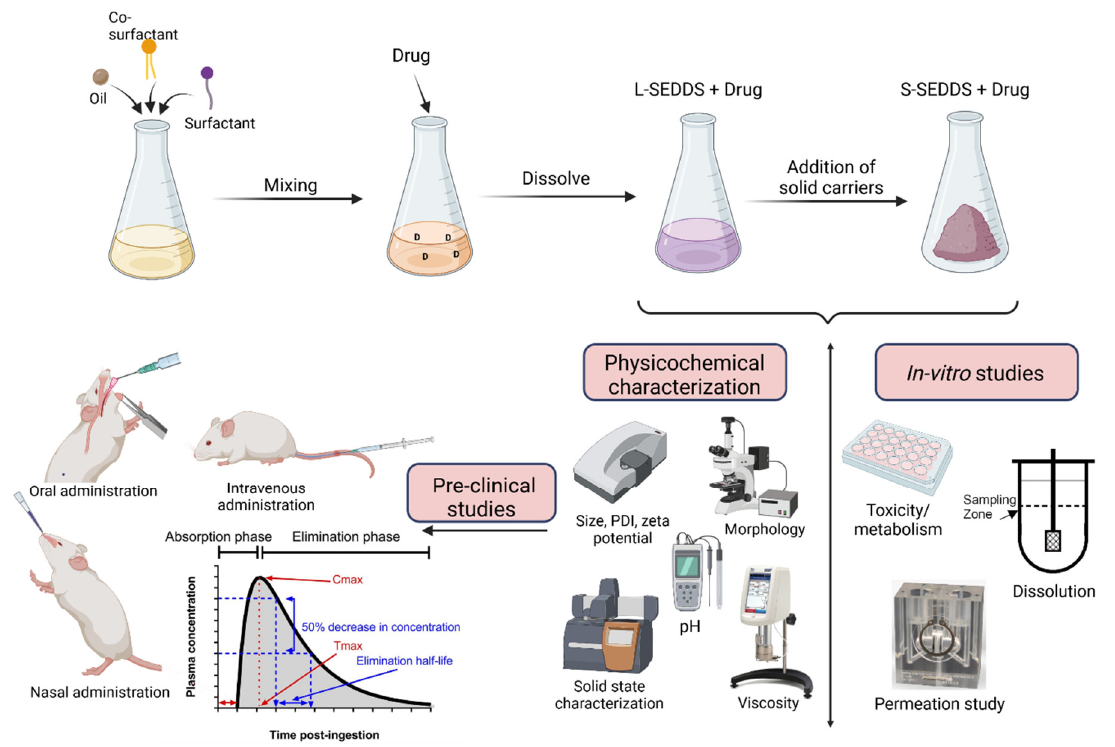
Figure 2. Preparation of self-emulsifying drug delivery systems (SEDDS) in the liquid (L-SEDDS) or solid (S-SEDDS) state together with the main techniques used for physicochemical characterization, in vitro evaluation, and implementation of in vivo studies. Created with BioRender.com, accessed on 17 July 2022.